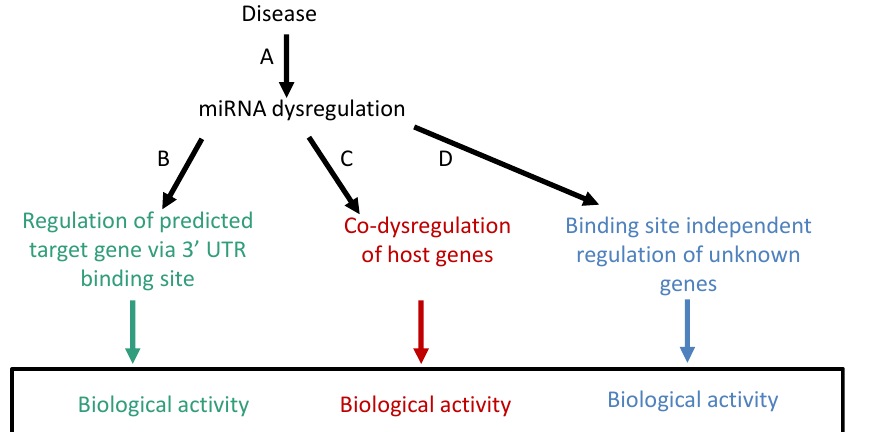
Figure 1. Problems and weaknesses of inferring miRNA biological activity using the target gene